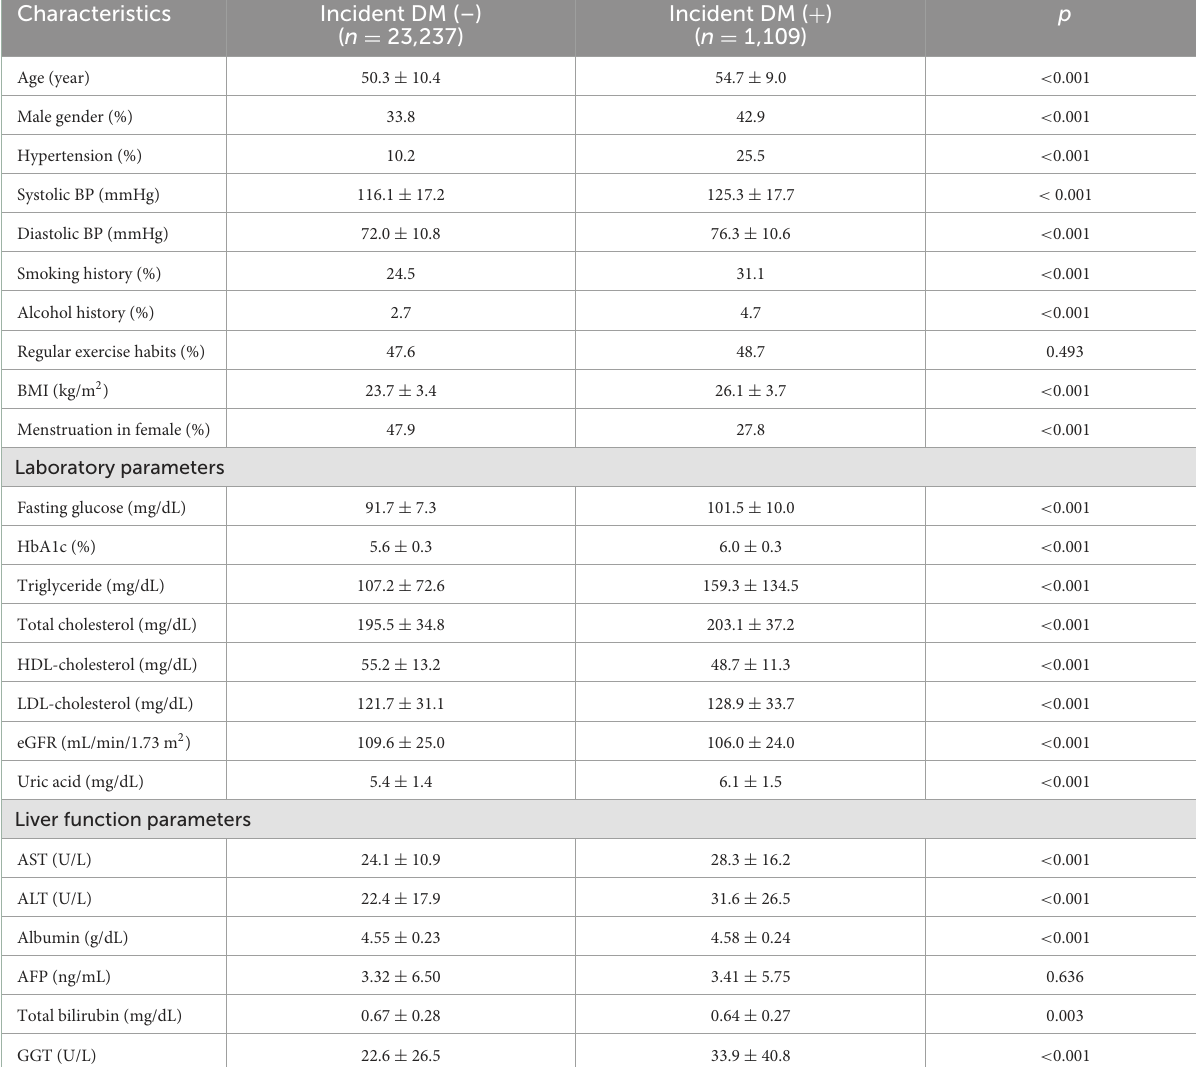
TABLE 1 Comparison of clinical characteristics among participants without or with incident DM.